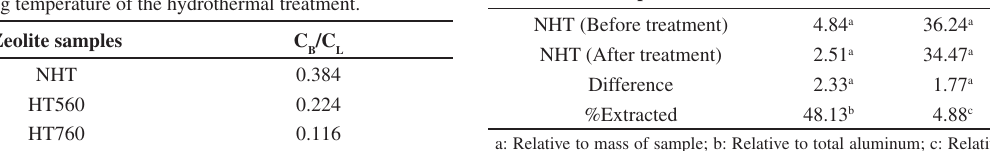
Figure 10. TPD-NH profiles of zeolite sample NHT a) before and 3 b) after treat with HCl 1N. Table 3. Elemental analysis of zeolite NHT, before and after superficial treatment, with HCl 1N, using Inductively Coupled Plasma (ICP) /C ratio with the B L